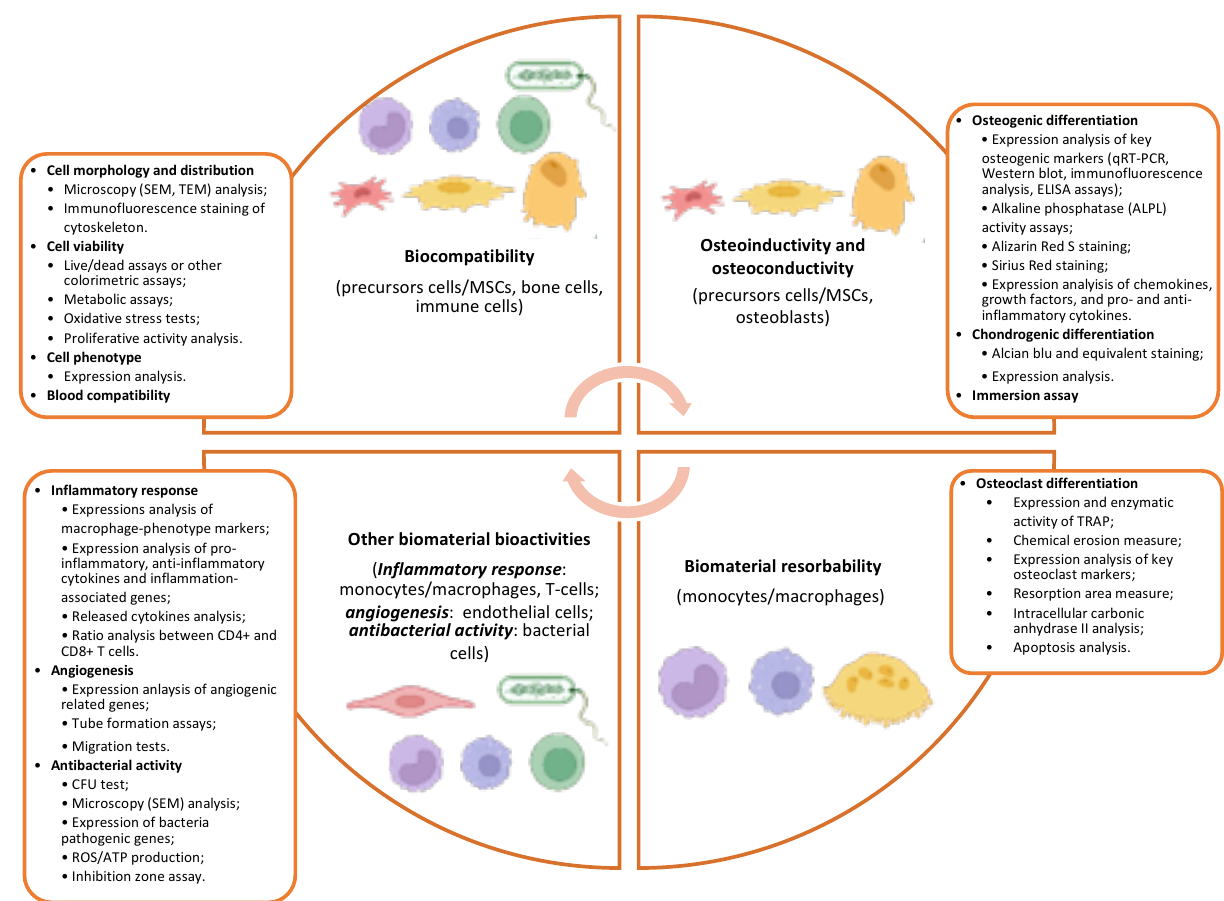
Figure 5. The scheme reports the most used methods to assess different biomaterial bioactive properties including biocompatibility, osteoinductivity, osteoconductivity, and